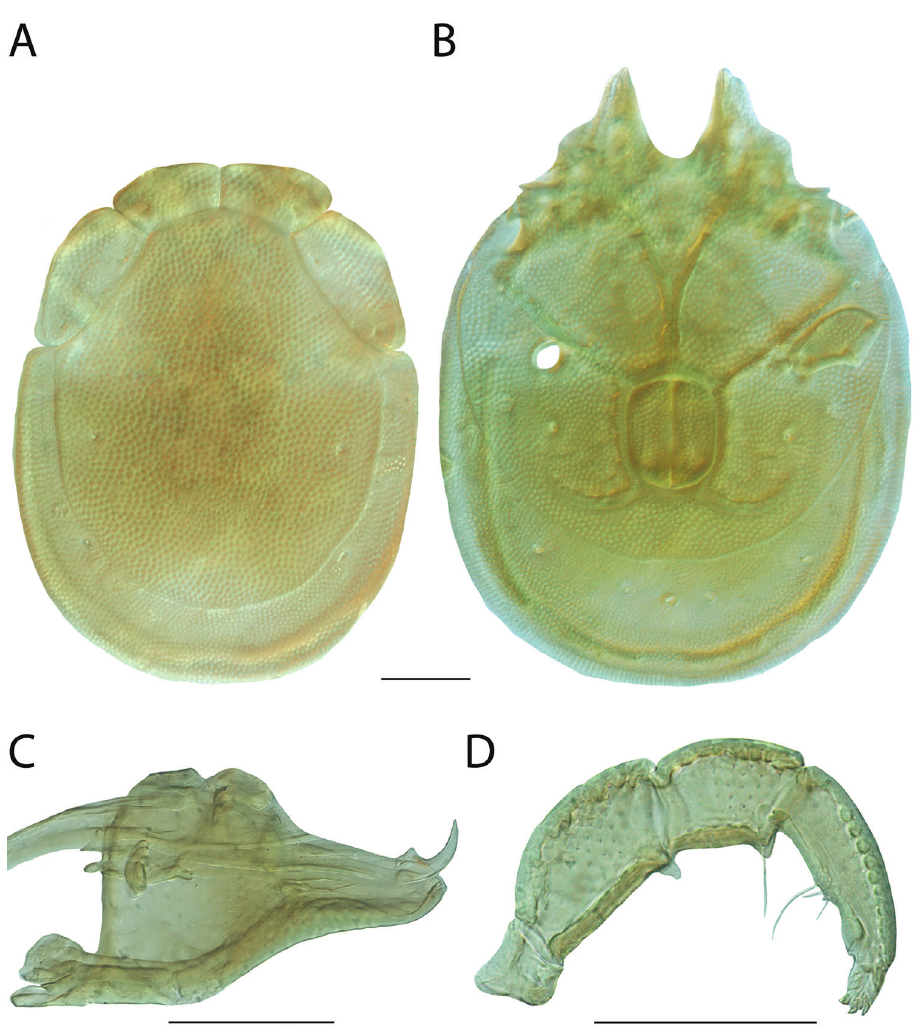
Figure 28. Torrenticola bittikoferae male: A dorsal plates B venter (legs removed) C subcapitulum D pe- dipalp (setae not accurately depicted). Scale = 100